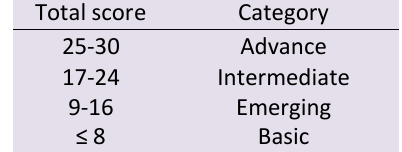
Table 2 . Written Communication Assessment